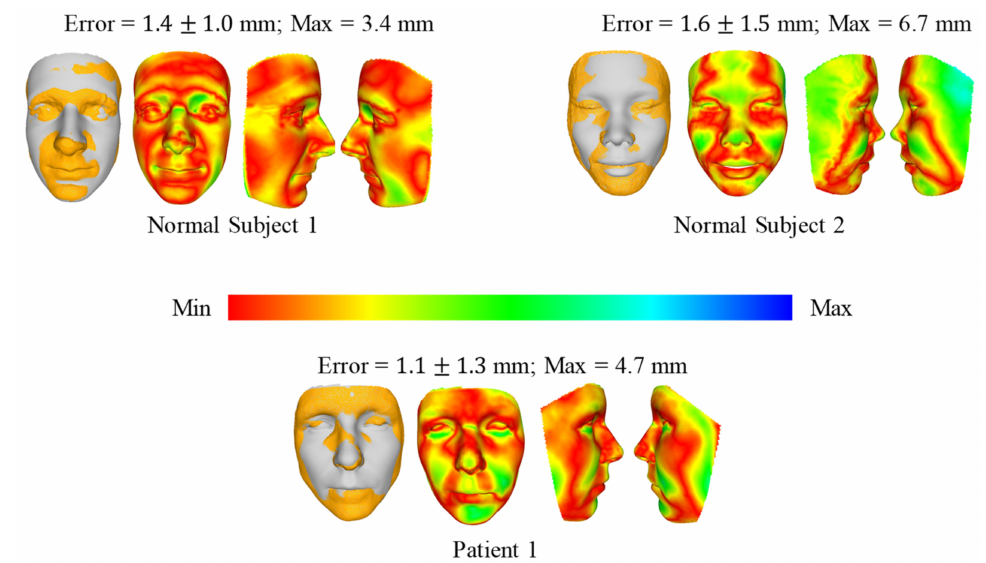
Figure 9. Comparison of 3D face reconstruction (grey) and 3D face reconstruction from MRI (yellow) using the third method (deep 3D face reconstruction).